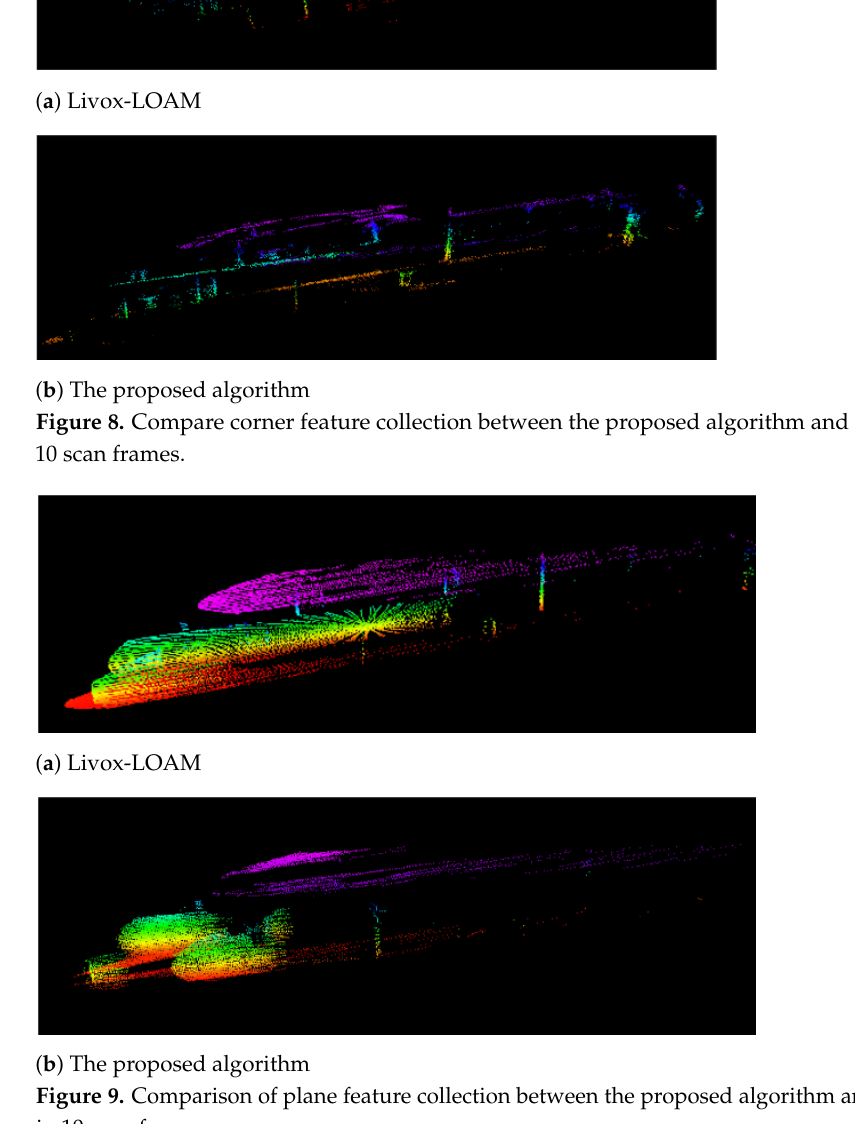
Figure 9. Comparison of plane feature collection between the proposed algorithm and Livox-LOAM in 10 scan